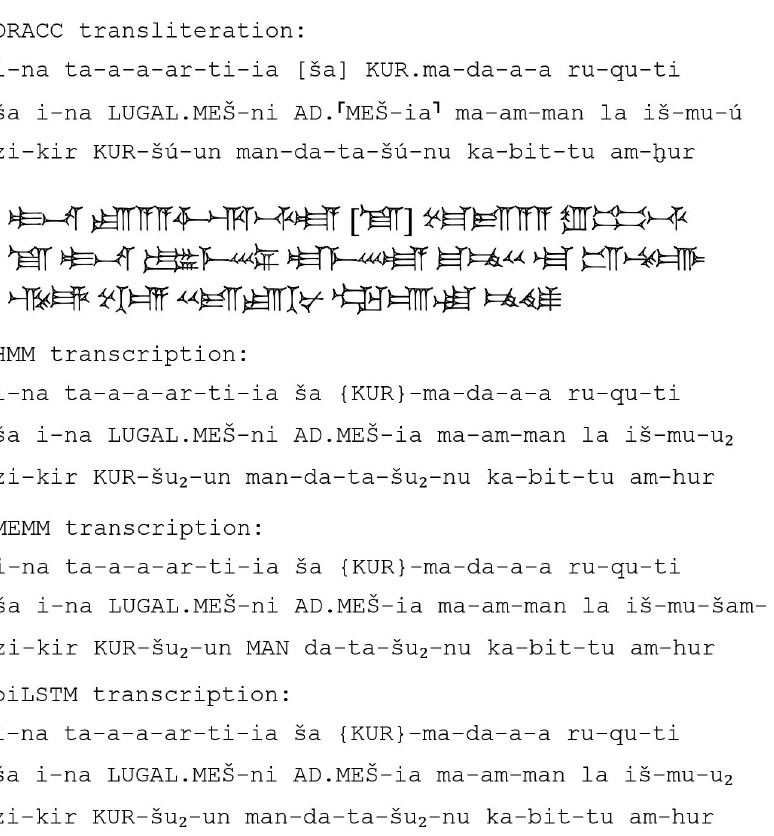
Fig 4. Output of the algorithms. These are lines 31-34 of the second column of Sennacherib’s clay prism, probably from Nineveh, now in the Israel Museum (IMJ 71.072.0249). The text records eight campaigns of the Assyrian King, including the siege of Jerusalem which is well known from the Book of Kings. The line reads: ‘On my return march, I received a heavy tribute from the distant Medes, of whose land none of the kings, my ancestors, had heard mention.’ (translation adapted from A.K. Grayson and J. Novotny’s edition available on ORACC, Q003497).